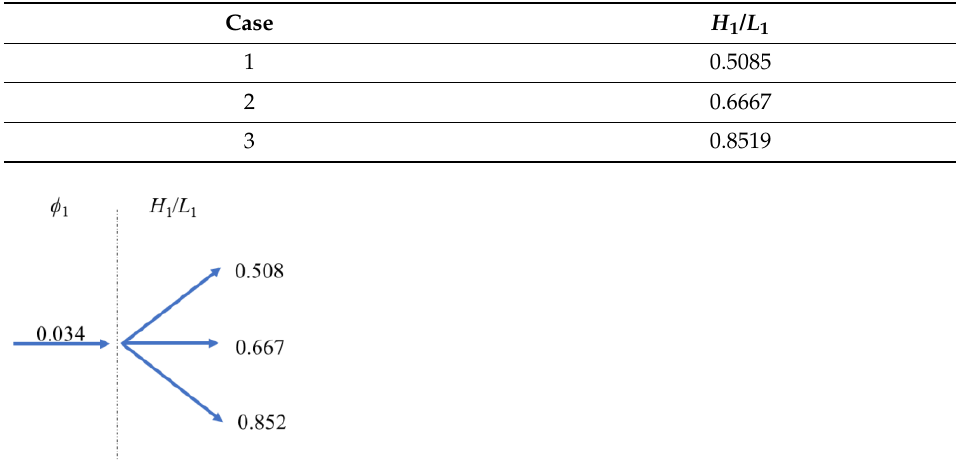
Table 2. Geometric evaluation of OTD-WEC with one ramp and one degree of freedom.